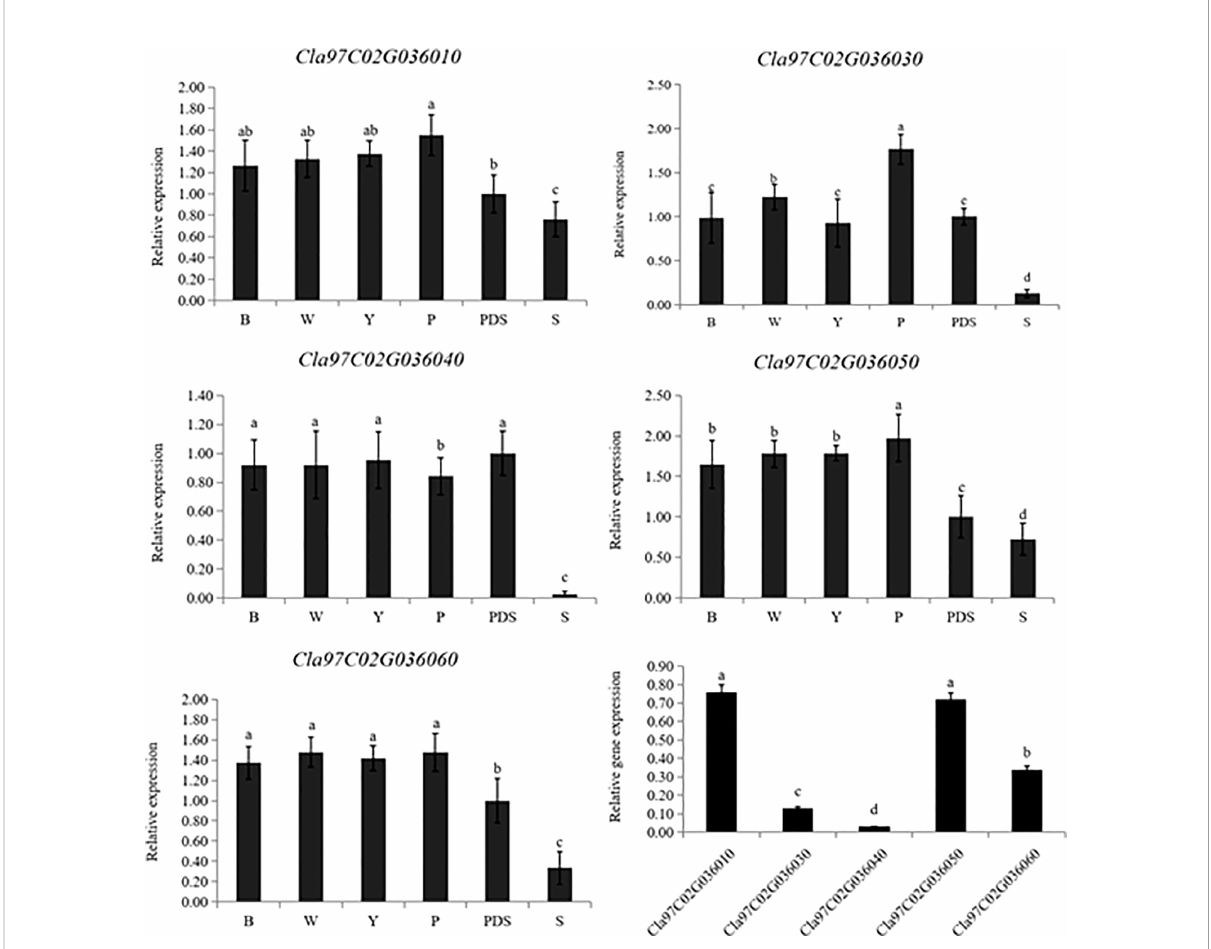
FIGURE 9 Expression levels of silenced genes. B, W, Y, P, PDS and S represents blank control, water control, YEP medium control, blank vector control, positive control and silenced genes, respectively. Small letters represent signi fi cant difference at